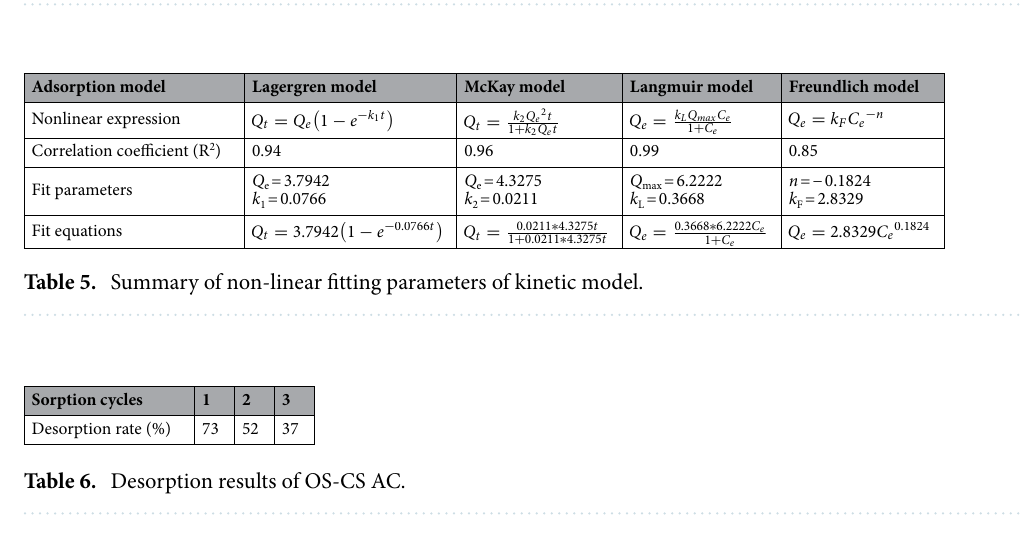
Table 4. Summary of linear fitting parameters of thermodynamic model.